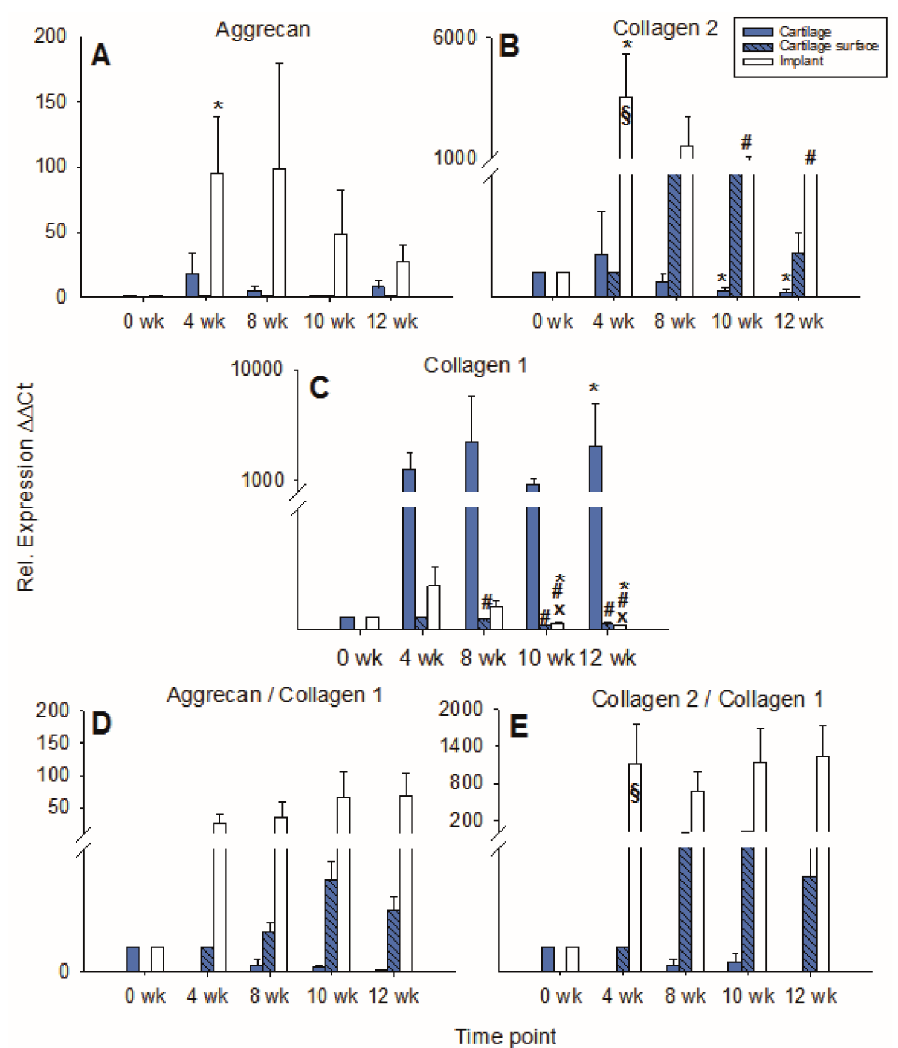
Figure 7. Real-time PCR analyses for cartilage matrix proteins (cell-loaded implants). mRNA levels for aggrecan ( A ), collagen 2 ( B ), collagen 1 ( C ), aggrecan/collagen 1 ratio ( D ), and collagen